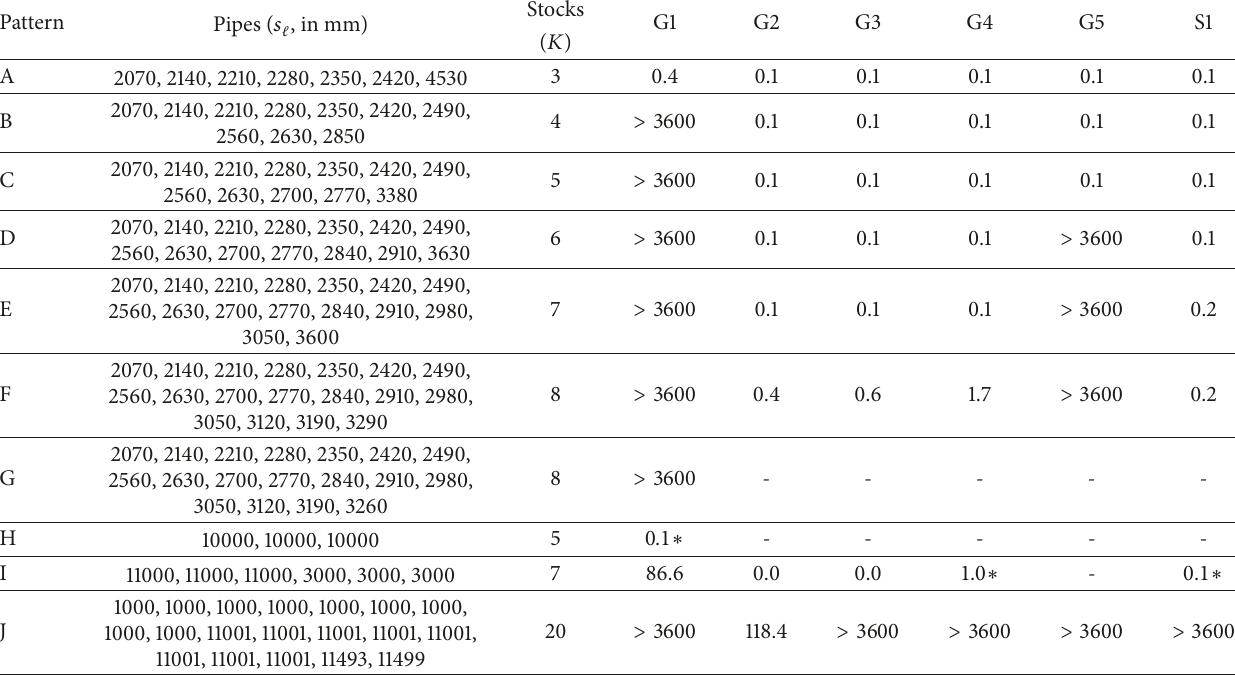
Table 2: Algorithm running times for minimal cutting-and-welding patterns ( ∗ = no minimal solution).